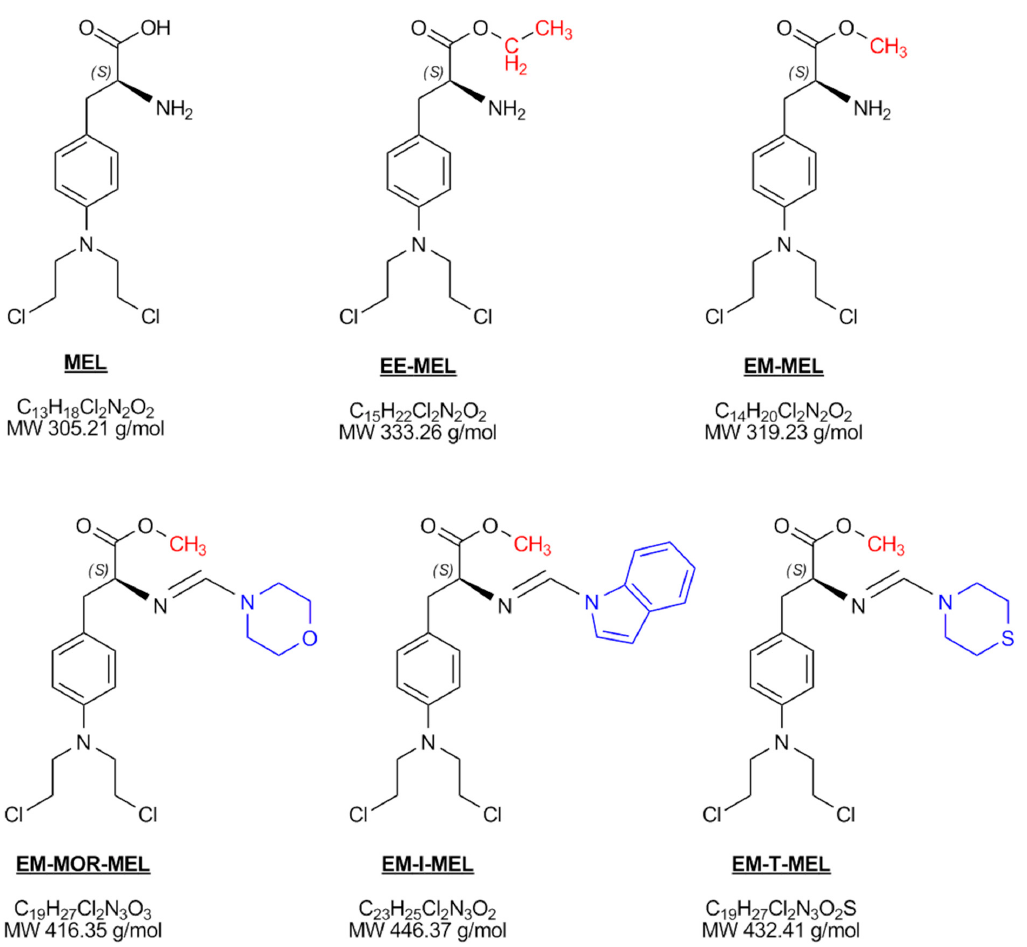
Figure 6. Chemical structure of melphalan (MEL) and its tested